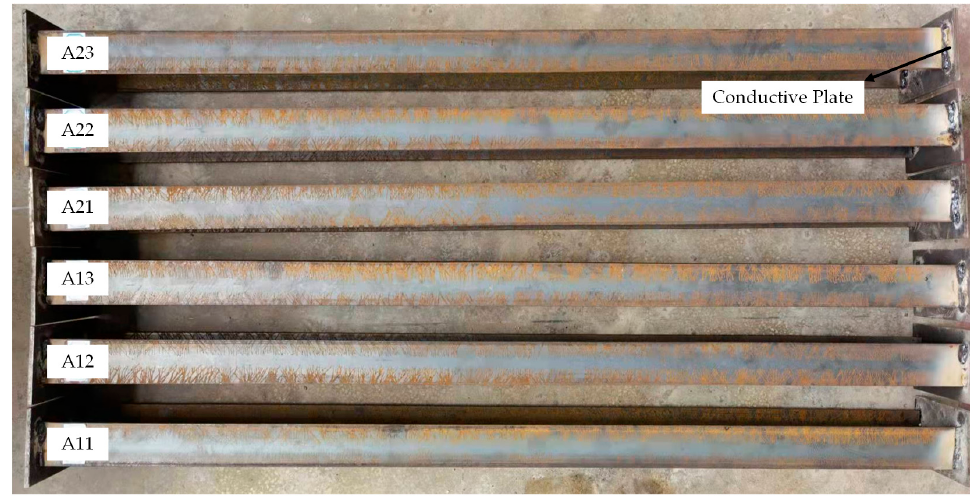
Figure 1. Specimens to be corroded.